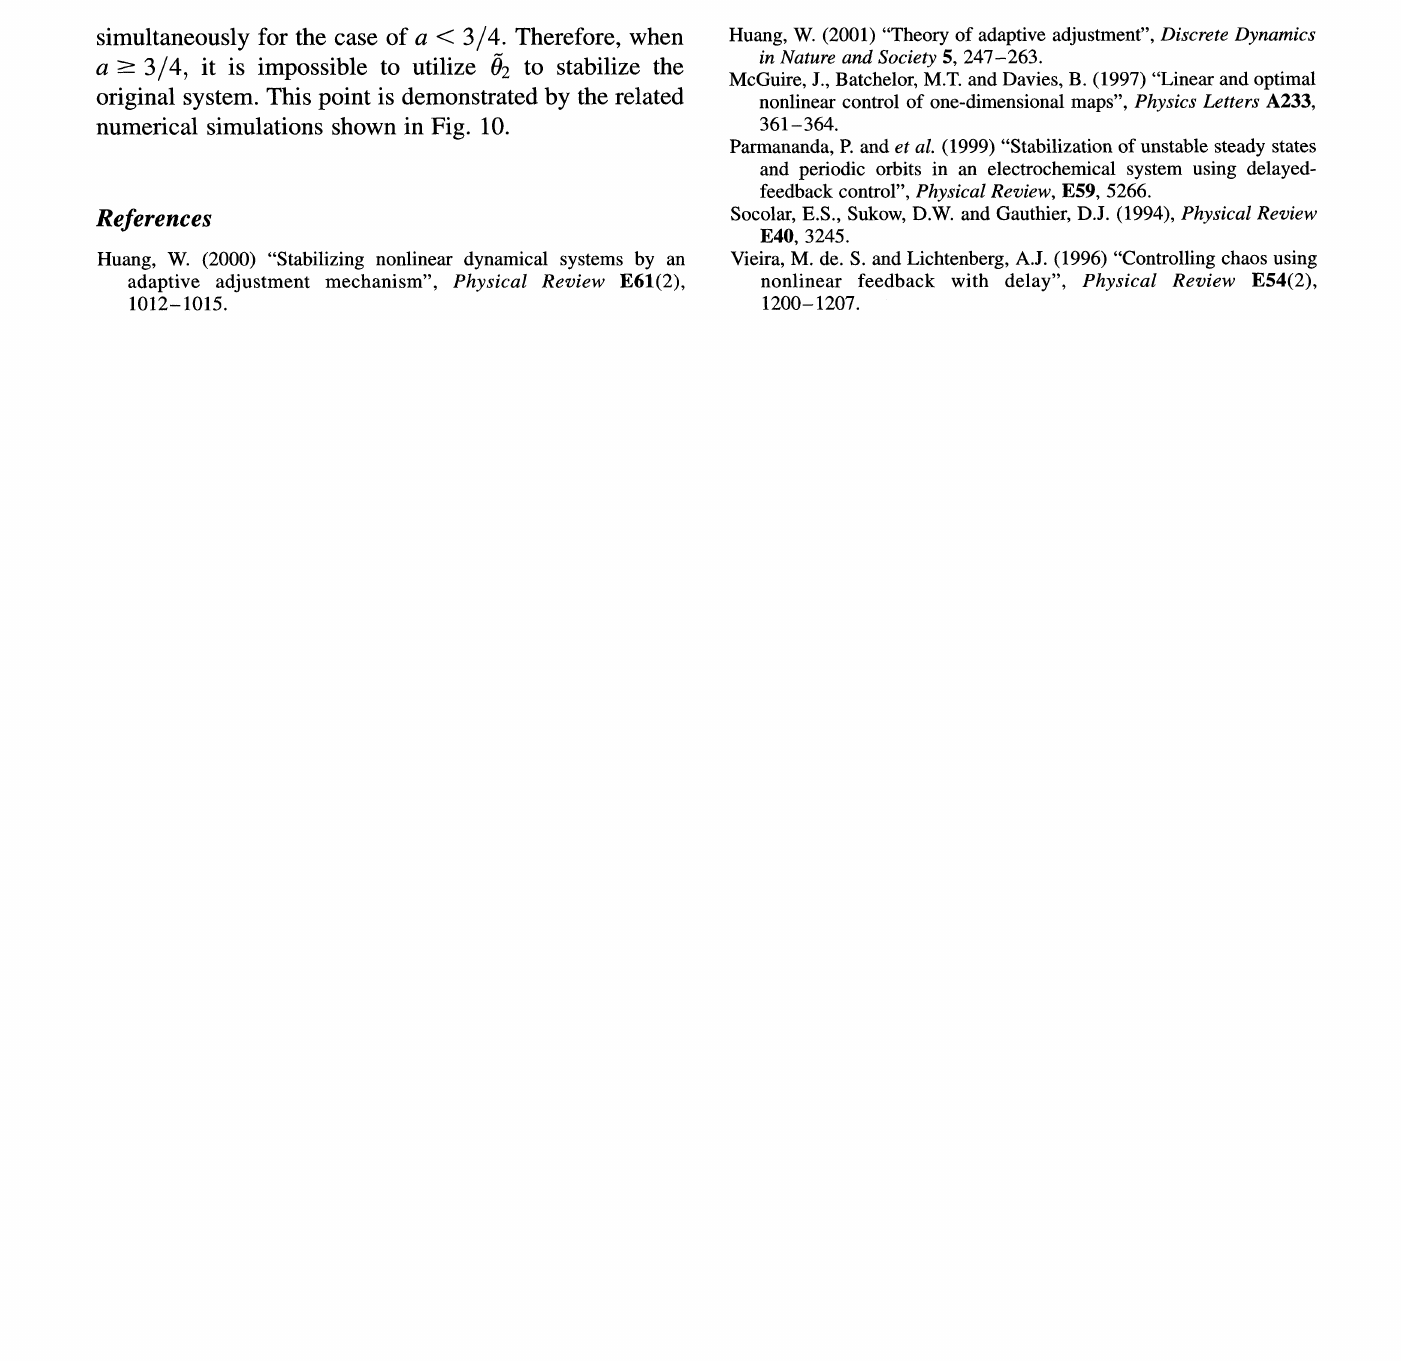
FIGURE 10 Trajectories ofxt-’- 2(Xt-l,Xt-2), ")/--